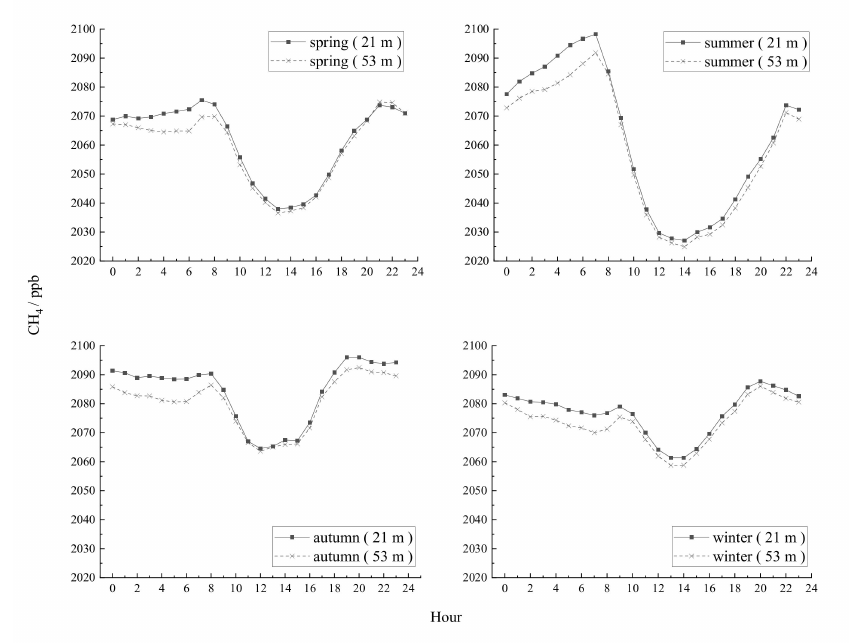
Figure 1. Hourly average CH 4 concentration changes at Lin’an